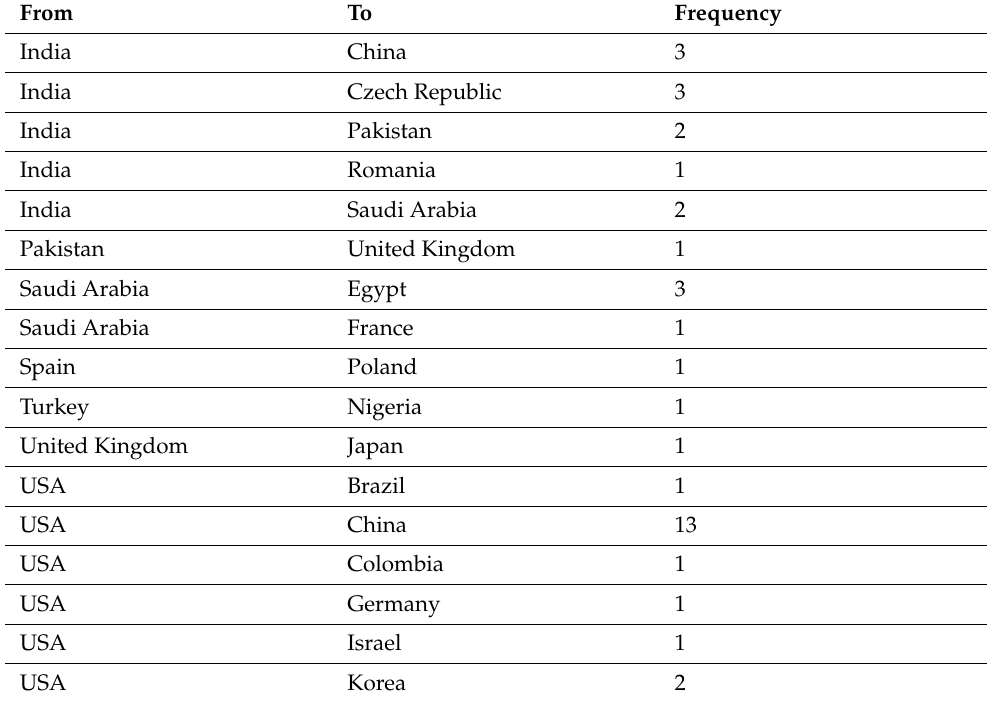
Table 7. Cont. From